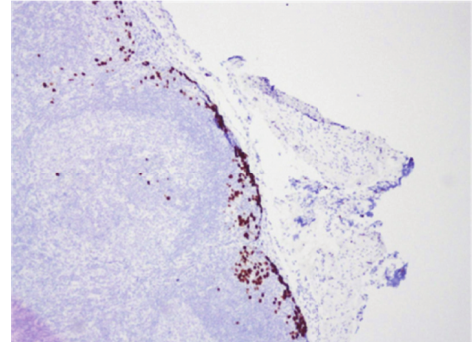
Figure 3: ALK-1 immunohistochemistry of sentinel lymph node demonstrating metastatic